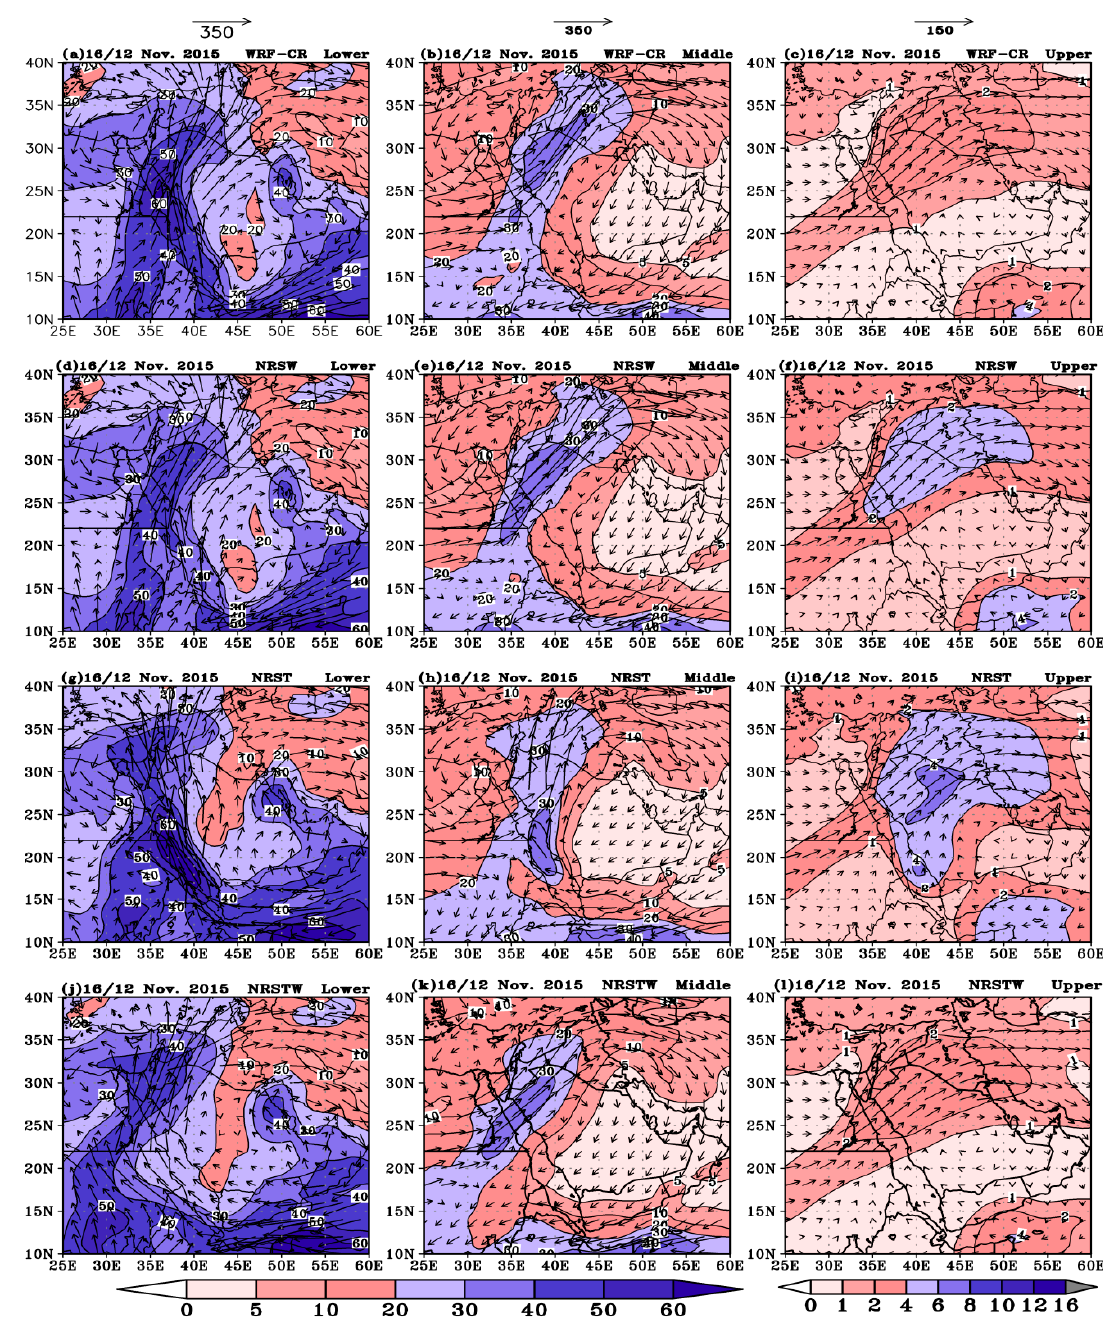
Figure 12. Rotational component of integrated moisture-flux (vector; kg m − 1 s − 1 ) for WRF-CR ( a – c ), NRSW ( d – f ), NRST ( g – i ), and NRSTW ( j – l ), along with precipitable water content (shaded; mm) in the three tropospheric layers: the lower layer with 1000–850 hPa ( c , f , i , l ), the middle layer with 700–500 hPa ( b , e , h , k ), and the upper with 400–100 hPa ( a , d , g , j ) for 12Z on 16 November 2015.